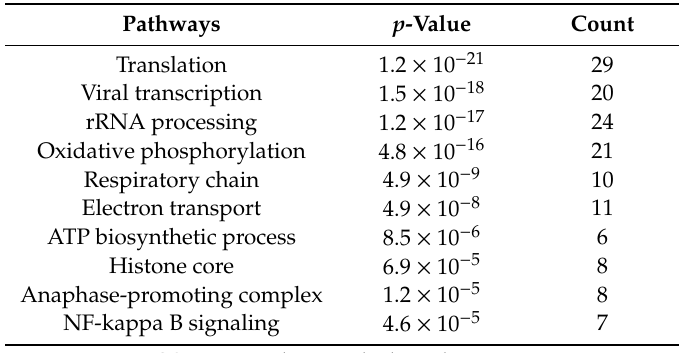
Table 2. The top 10 GO-BP terms downregulated in SNU449 and Huh7 by sofosbuvir. Pathways p